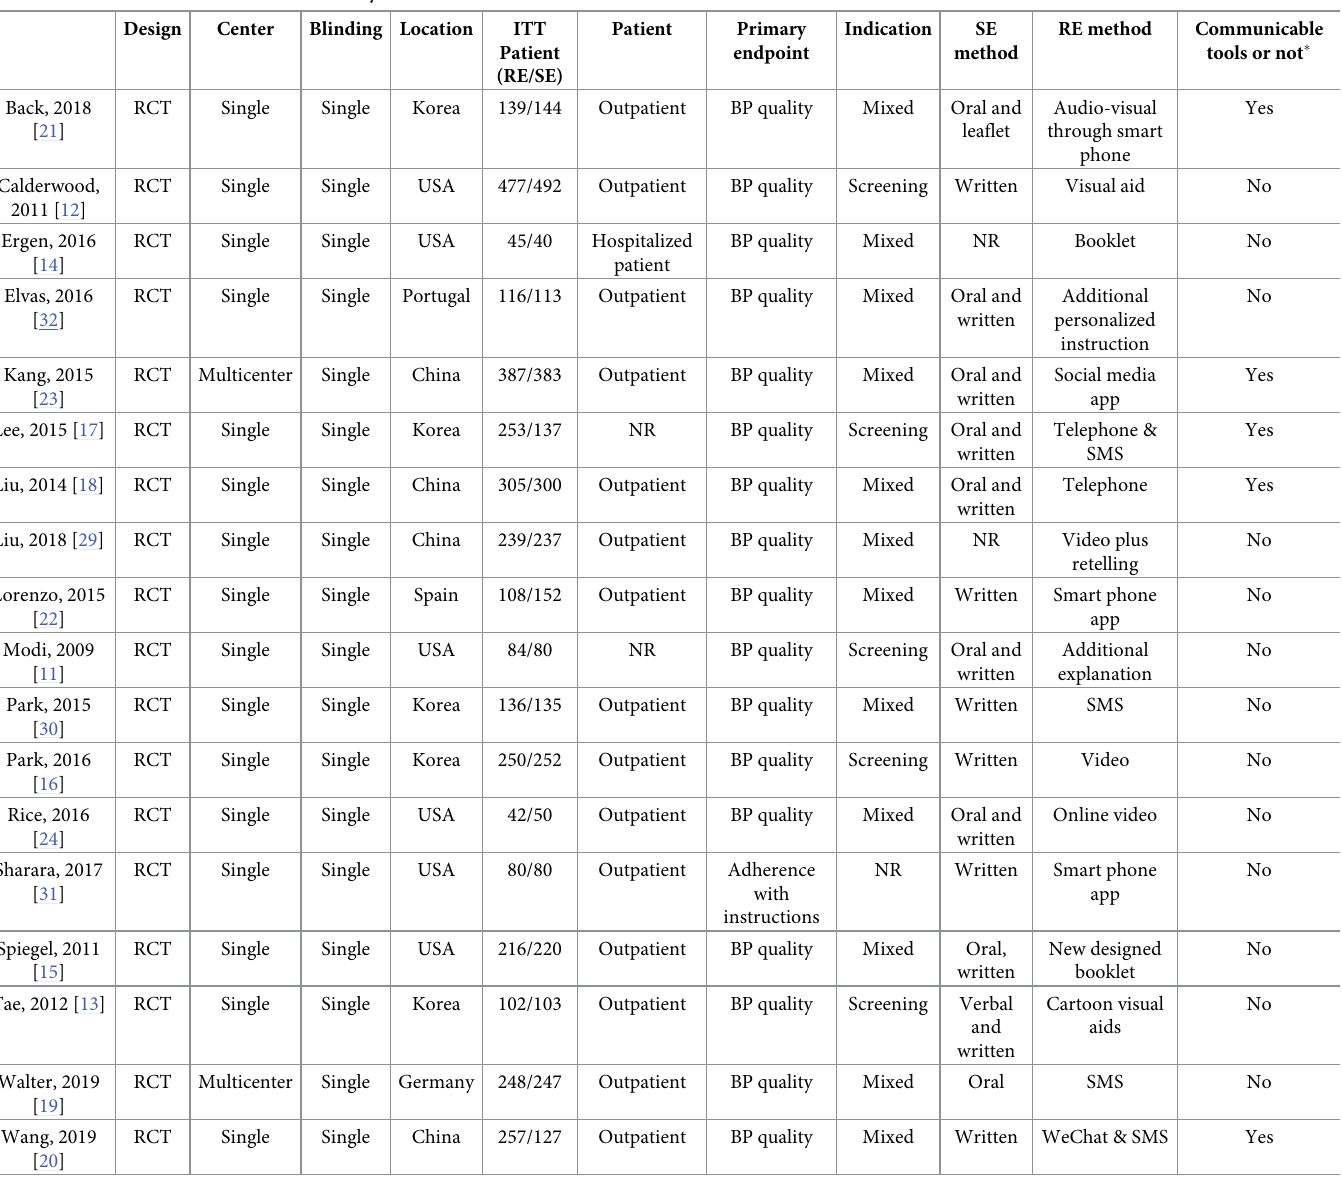
Table 1. Characteristics of each included